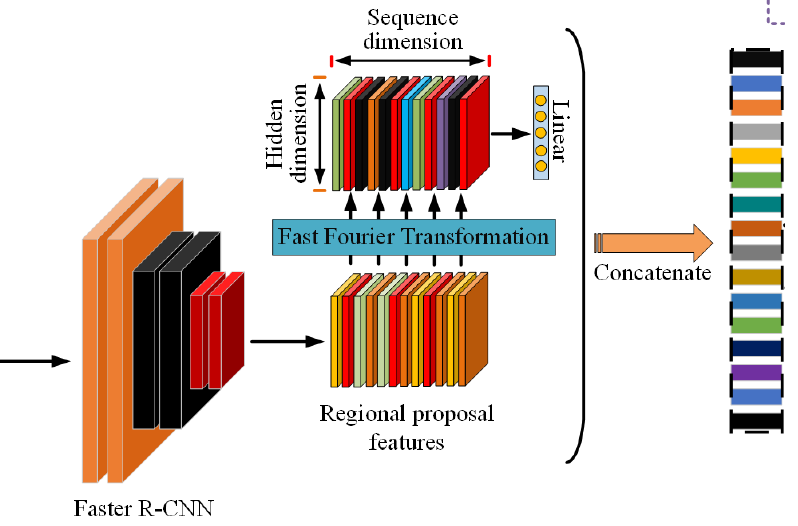
Figure 1. The fast Fourier transform extracted features fused with regional proposal features.